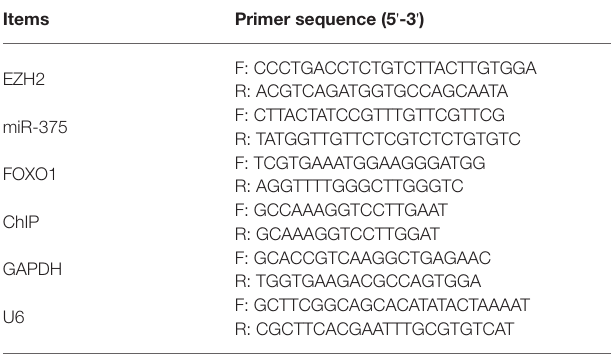
TABLE 2 | Primer sequences for RT-qPCR.